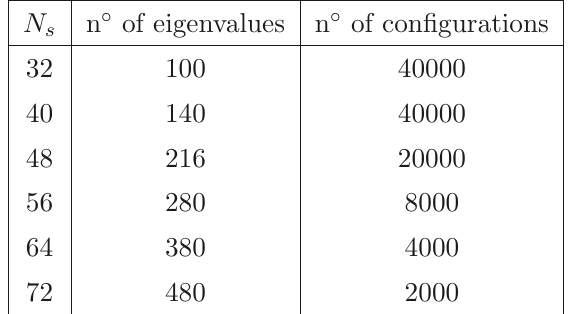
Table 1 . Number of eigenvalues and sample size for the various